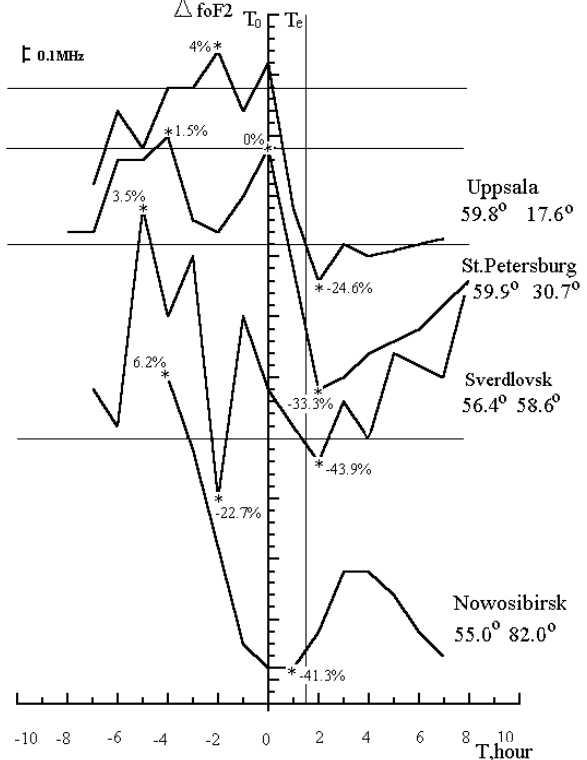
Fig. 10. The variations of 1 fo F2 values for the positive substorm that occurred on 05 March 1999 ( T o = 16:00UT or 16:00LT, I = + 220nT, τ = 1 . 5h) through the second (southern) longitudinal chain of stations of the IDCE, LT = UT. The vertical lines mark substorm onset, T o , and the end of the substorm, T e . Asterisks are δ fo F2 (%) values.